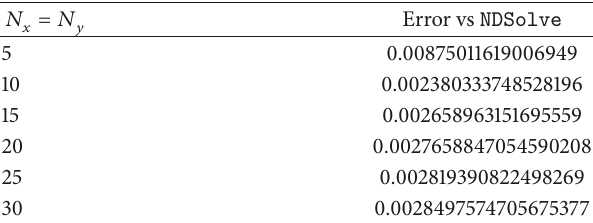
Table 4: Maximum absolute error in the presented method’s solution of the problem described by Example 4 at time 𝑡 = 1